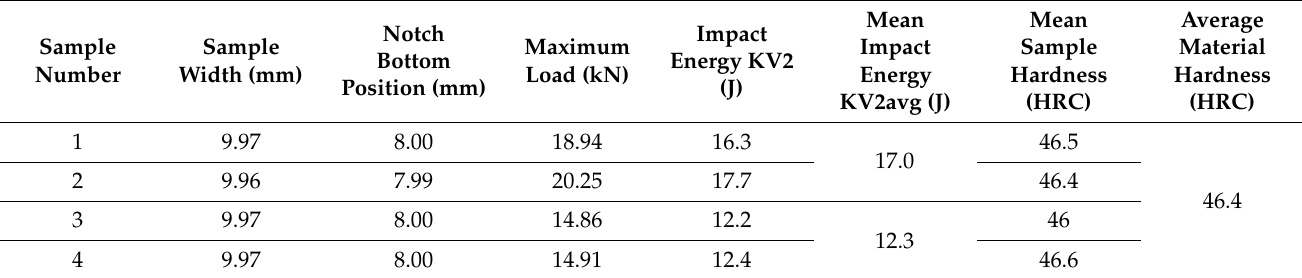
Table 3. Samples’ dimensions and tests